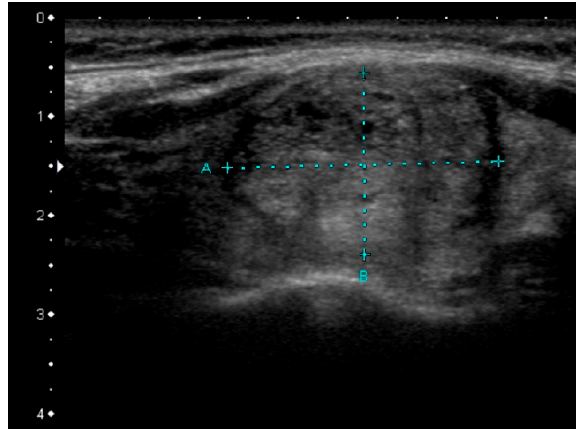
Figure 4. Sonographic pattern of RAS -positive papillary thyroid carcinima, slightly hypoechoic, heterogeneous lesion with rather well-defined margins.